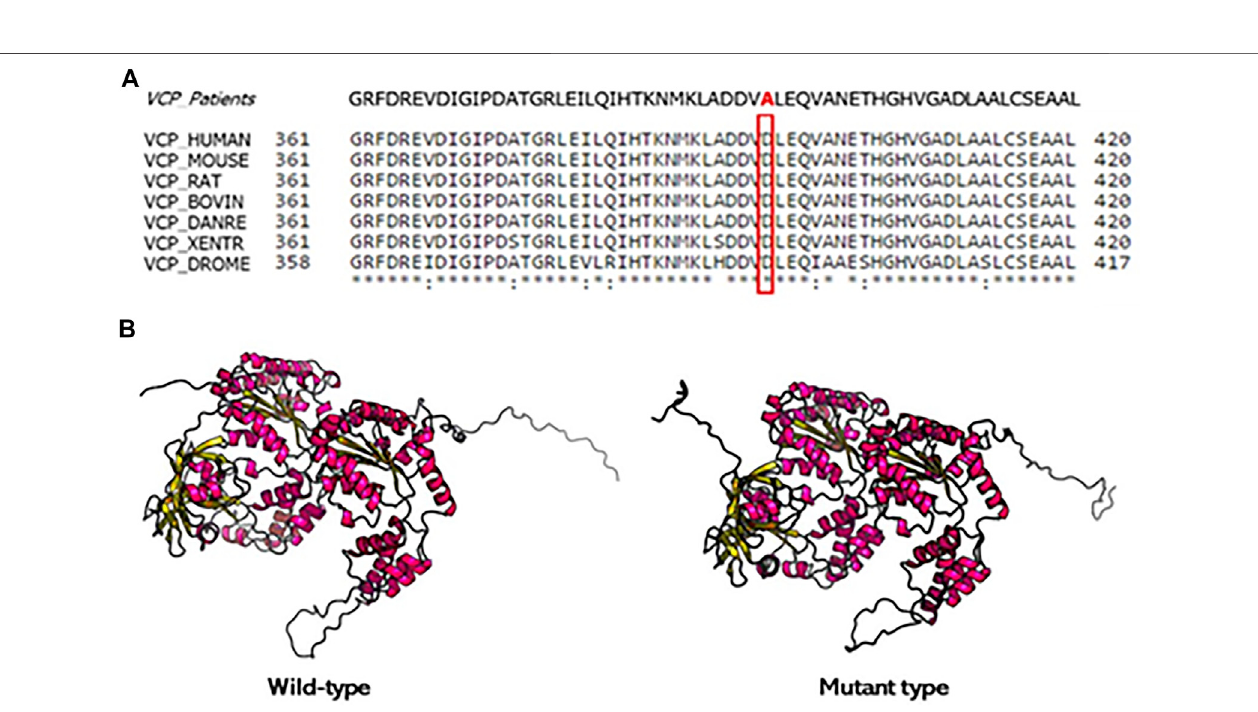
FIGURE 4 | Conservation analysis of the mutation site and protein structure modeling of VCP. (A) Alignment of VCP sequences from different species. Mutated residueisboxed. (B) The3Dproteinstructure modelingwildtypeandmutationtypeofVCPprotein.TheD395Amutationchangestheresiduesidechainatthepositions 395 of VCP